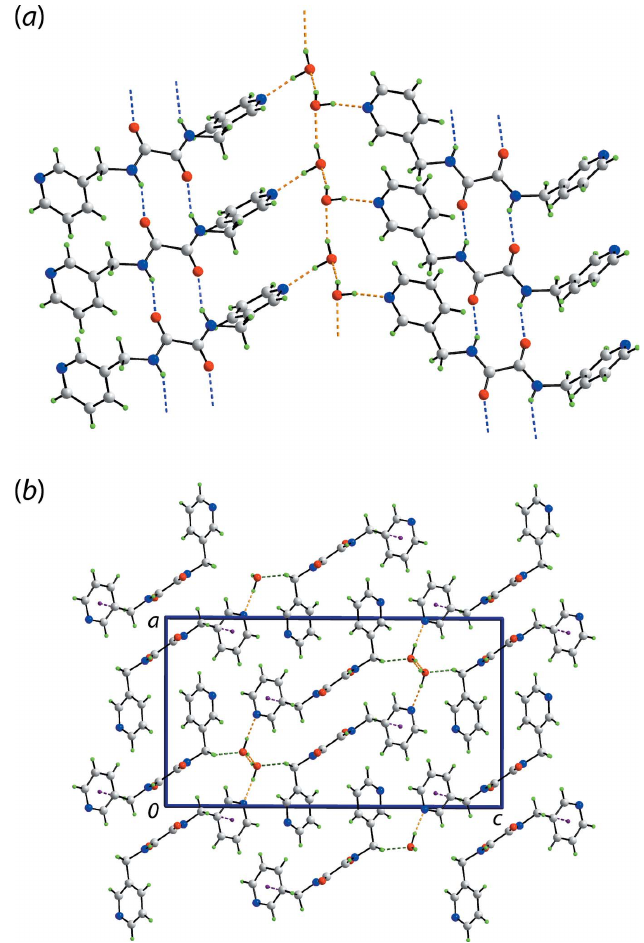
Figure 2 Molecular packing in the crystal of (I): ( a ) one-dimensional chain whereby tapes sustained by amide-N—H (cid:2)(cid:2)(cid:2) O(carbonyl) hydrogen bonds and ten-membered { (cid:2)(cid:2)(cid:2) HNC 2 O} 2 synthons are connected, via water-O— H (cid:2)(cid:2)(cid:2) N(pyridyl) hydrogen bonds, by helical chains of hydrogen-bonded water molecules sustained by water-O—H (cid:2)(cid:2)(cid:2) O(water) hydrogen bonds and ( b ) a view of the unit-cell contents in projection down the b axis, highlighting the stacking of layers. The amide-N—H (cid:2)(cid:2)(cid:2) O(carbonyl) hydrogen bonds are shown as blue dashed lines and hydrogen bonds involving the water molecules, by orange dashed lines. The C—H (cid:2)(cid:2)(cid:2) O and C—H (cid:2)(cid:2)(cid:2) (cid:2) interactions are shown as green and purple dashed lines,